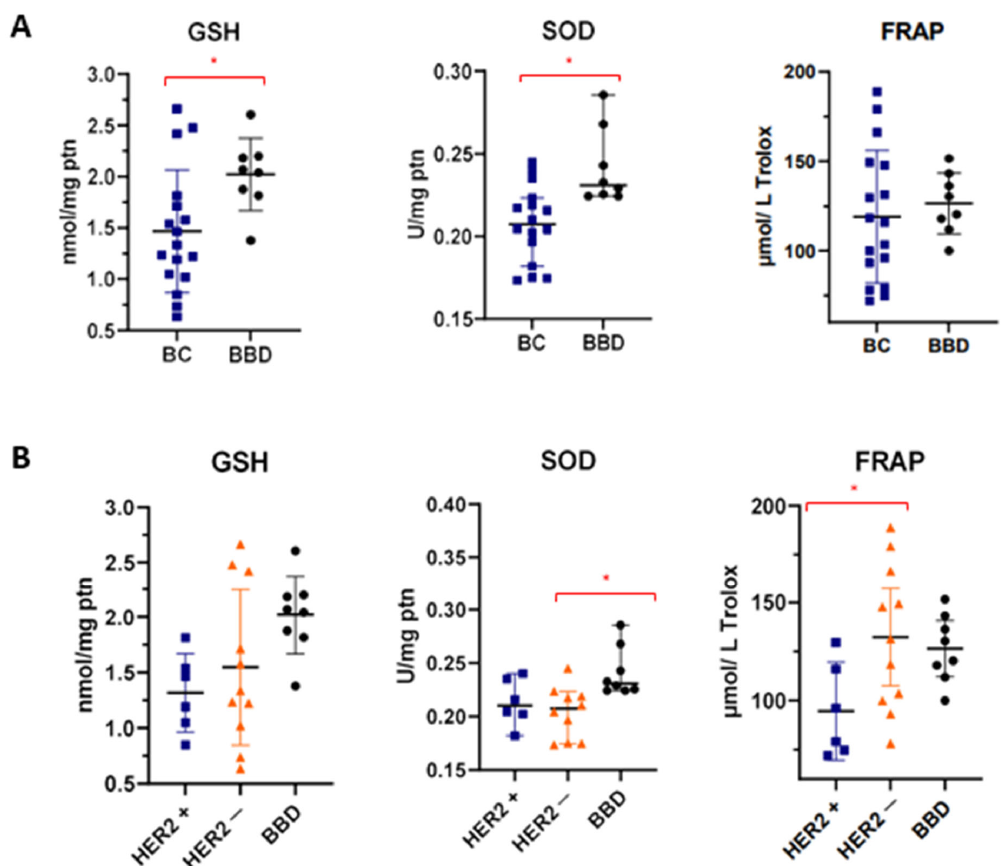
Figure 4. Redox status biomarkers levels in BC, HER2+, HER2 − and BBD women. ( A ) GSH, SOD and FRAP levels in BC and BBD women; ( B ) GSH, SOD and FRAP levels in HER2+, HER2 − and BBD women. *, denotes statistical difference between the two highlighted groups. In order to obtain a cut ‐ off point at which it is possible to discriminate the studied groups based on their redox status, the ROC curve analysis was performed. In this step, Figure 5 presents the analyzes with p < 0.05. For FRAP a cut ‐ off point of <117 was found to discriminate women with HER2+ BC from women with BBD (specificity 75% and sensitivity 83.33%). Furthermore, this same antioxidant capacity marker also discriminates against women with HER2+ BC from those with HER2 − BC, with a cut ‐ off point < 97.96 (specificity of 81.82% and sensitivity of 66.67%).